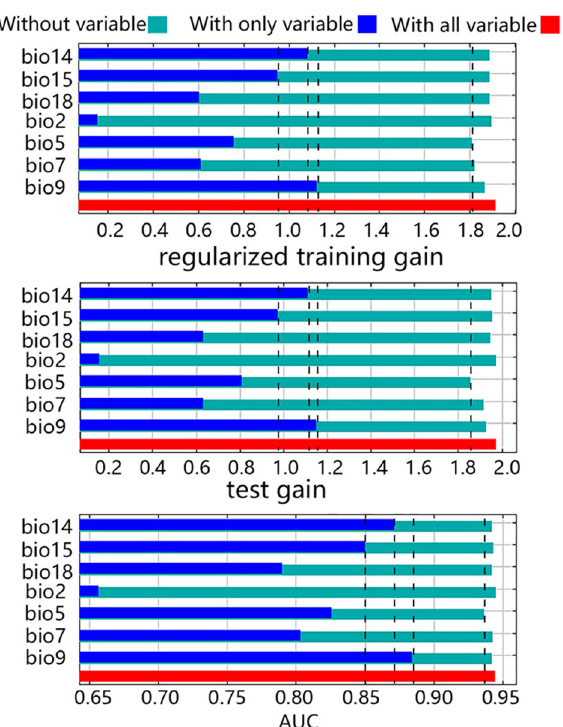
Figure 3. The jackknife test of the MaxEnt prediction model for the prediction of the global suitable habitats of N. alata